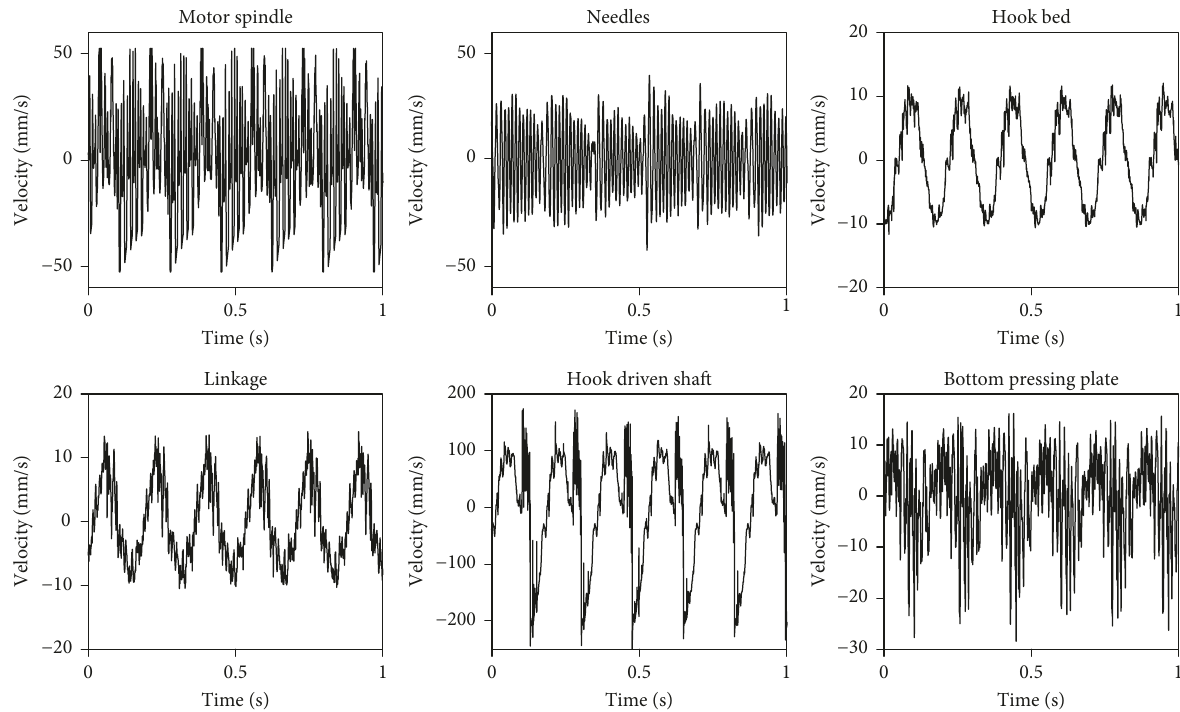
Figure 7: Time domain waveforms of vibration